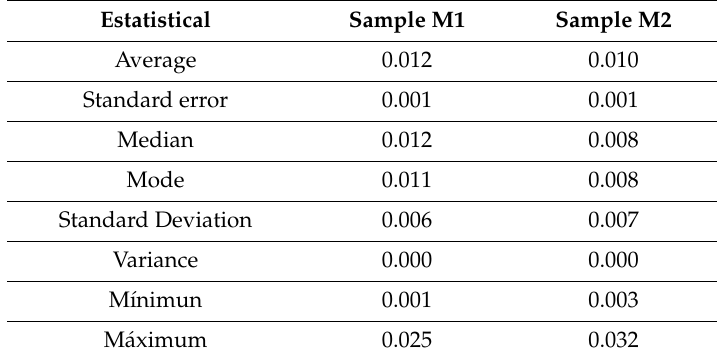
Table 5. Main descriptive statistics of samples M1 and M2 (units: m).